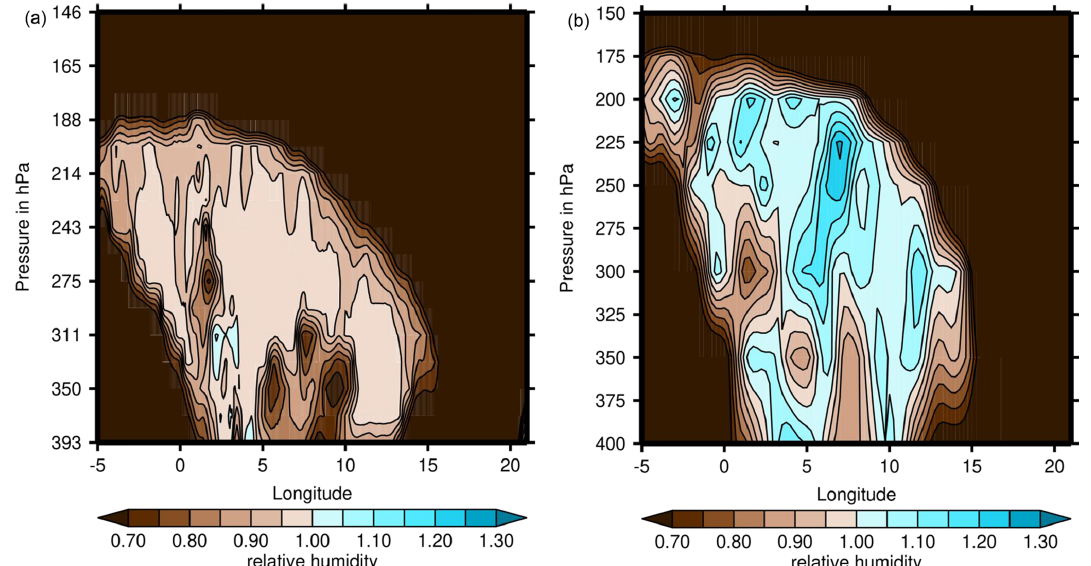
Figure 3. Latitude–altitude plots of relative humidity with respect to ice on 21 March 2021, 18:00UTC, along 52 ◦ N. (a) Data from ICON- EU. (b) Data from ERA5. In this figure, we display only the upper troposphere and lowermost stratosphere. Please note the different pressure scales in both